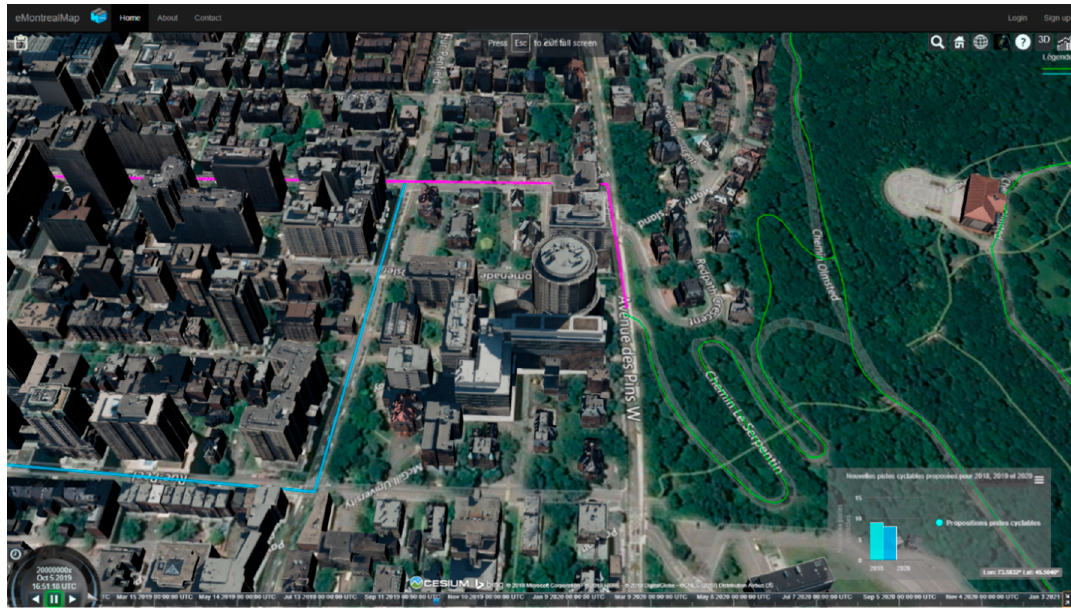
Figure 3. User case #1 with selected bicycle paths in pink, future bicycle paths in blue, current bicycle paths in green, and realistic textured buildings with a Bing basemap imagery.